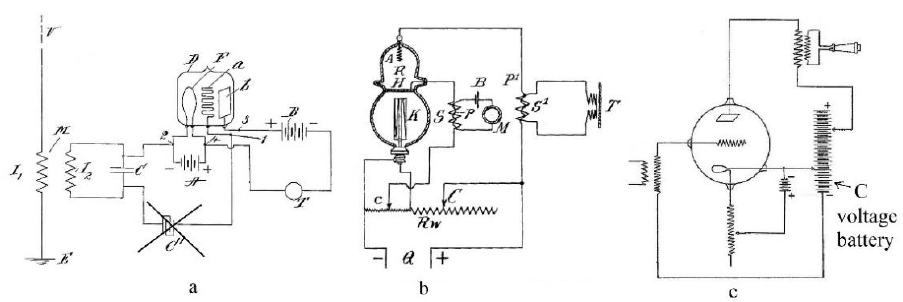
Fig. 4. Radio circuit without capacitor C' (a), telephone amplifier (Figure b from US1038910) and audio amplifier circuit Lowenstein with bias battery C (c).